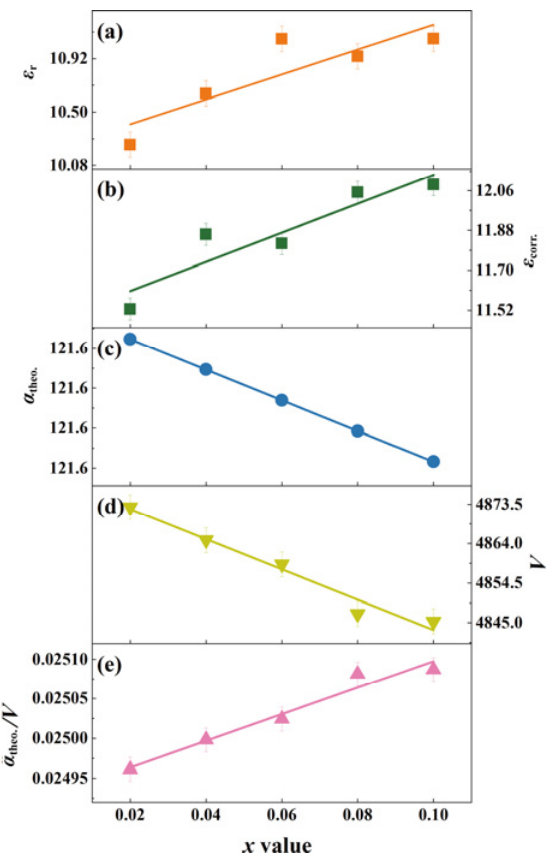
Fig. 7 (a) ε r , (b) ε corr. , (c) α theo. , (d) V , and (e) α theo. / V of Fig. 8 (a) ε corr. , (b) average ionicity ( f i ,ave ) of all bonds, and (c) f i ,Zr(Ti)–O of NZ 1 − x T x M ( x = 0.02–0.10) ceramics sintered at optimal